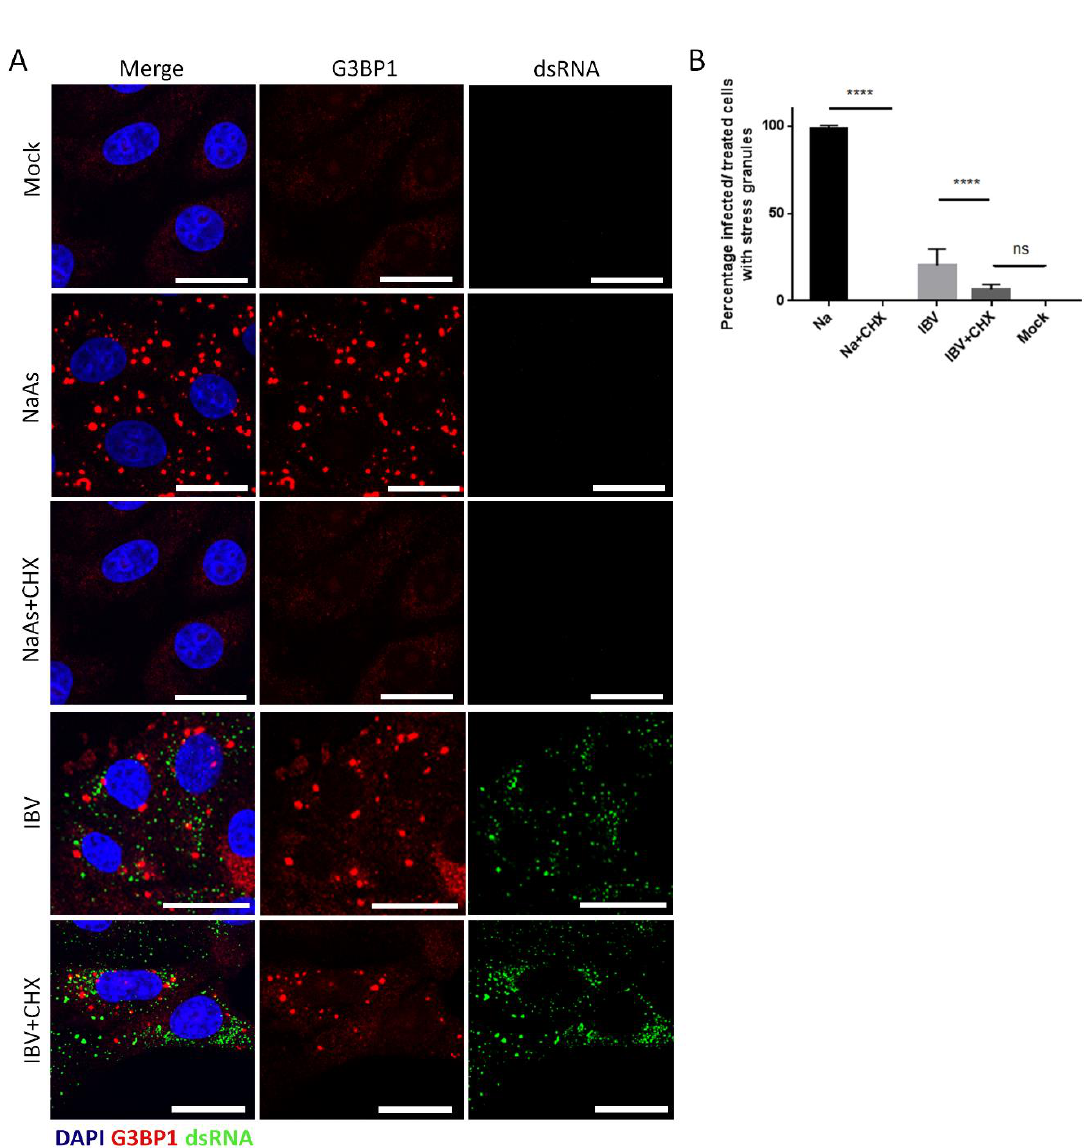
Figure 4. IBV induced stress granules are dissolved by cycloheximide treatment. ( A ) Vero cells were mock infected or infected with IBV. Where indicated cells were treated with sodium arsenite (NaAs). Cells were then mock treated or treated with cycloheximide (CHX) to dissolve SG. At 24 hpi, cells were fixed and labelled with anti-G3BP1 (red) to detect stress granules (SG) and IBV infected cells were detected with an anti-dsRNA antibody (green). Nuclei were stained with DAPI (blue). Scale bar indicates 20 µm. ( B ) Images from ( A ) were quantified to determine the percentage of cells containing SG. A minimum of 50 cells were counted. Mean and standard deviation of three independent replicates are shown. Asterisks indicate statistical significance, as measured by one-way ANOVA, **** p < 0.0001; ns, not significant.